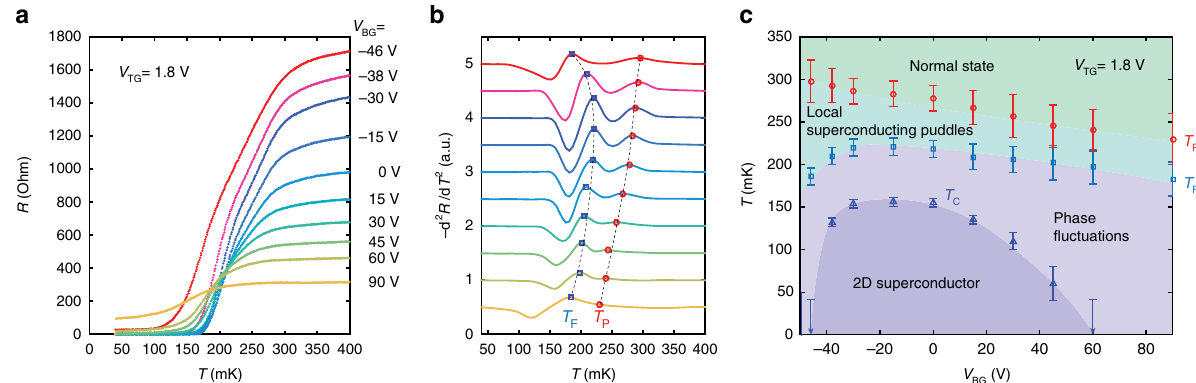
Fig. 3 Back-gate modulation of the interface ground state. a Sheet resistivity versus temperature ( R – T ) curves as a function of V BG from − 46 to 90 V with fi xed V = 1.8 V. b The second-order derivative calculated using a spline fi t of the R – T curves shown in a . Red circles and blue squares indicate the local TG maxima of the peaks, de fi ning T P and T F . Curve colours are matched between a and b . c Phase diagram for back-gating with fi xed V TG = 1.8 V. Red circles, blue squares, and blue triangles represent T P , T F , and T C , respectively. Normal state here indicates a non-superconducting state. Error bars are de fi ned by the full width of the second derivative peaks for T P and T F . T C is de fi ned as the temperature at which the sheet resistivity drops to 1% of the normal state R N (400 mK). The lowest temperature measured for our R – T curves is 40 mK, so data points estimated to be <40 mK are plotted with arrows. Background colours are guides to the eye indicating the different